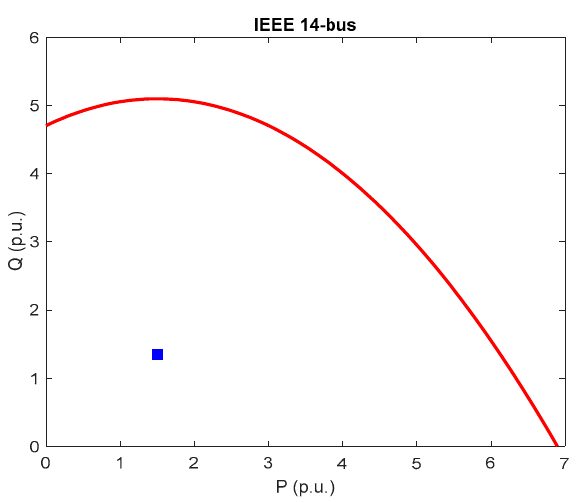
Figure 13. VSB in P-Q plane for IEEE 14-bus model. The point at (1.5, 1.35) is the initial operating point. Table 5. Comparison of the results in terms of EC avg for the considered test systems.